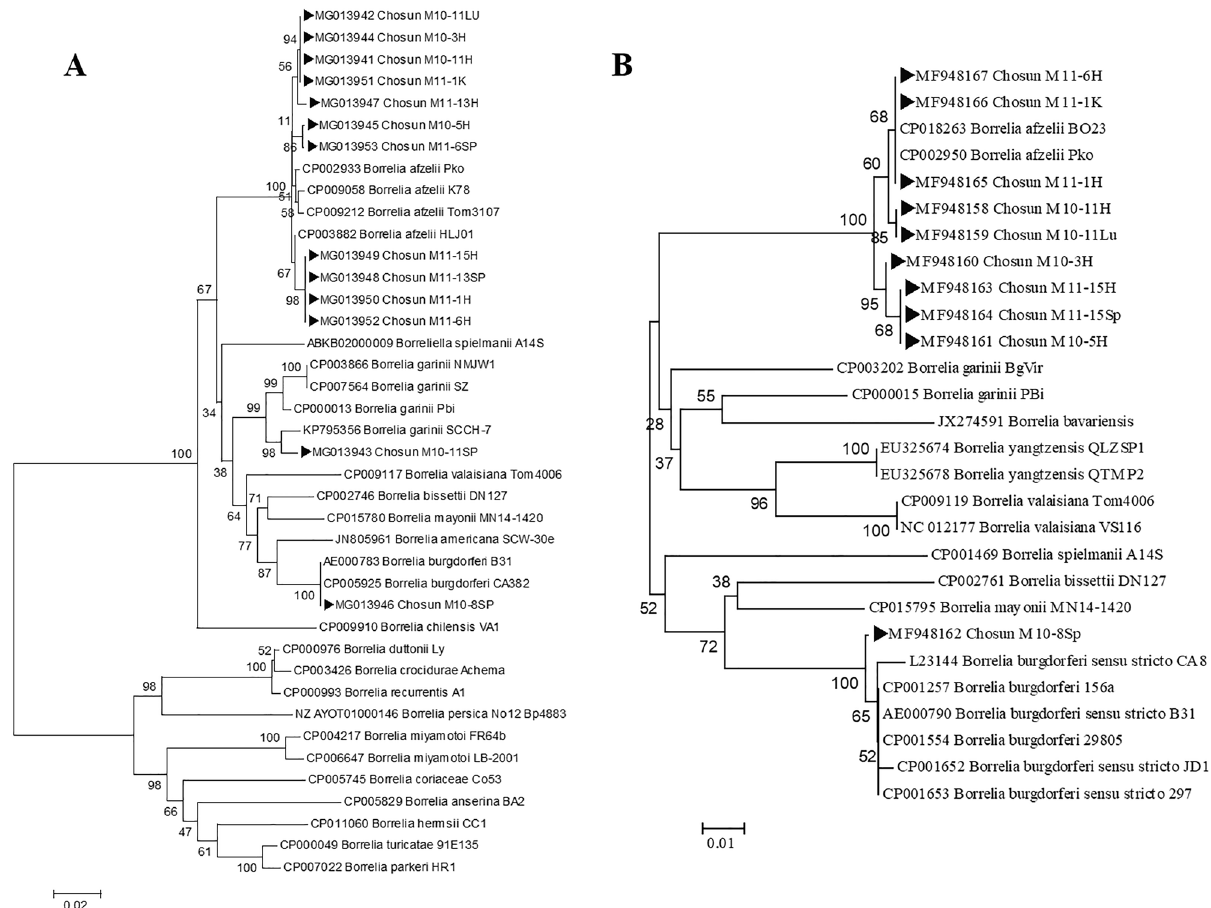
Figure 1. A phylogenetic tree constructed using the pyrG ( A , 675 bp) and ospA ( B , 285 bp) sequences retrieved from GenBank and obtained from the tissue DNA of the wild rodents captured (▶). The scale bars indicate 0.02 ( A ) or 0.01 ( B ) base substitutions per site. The GenBank accession numbers are shown in the tree.